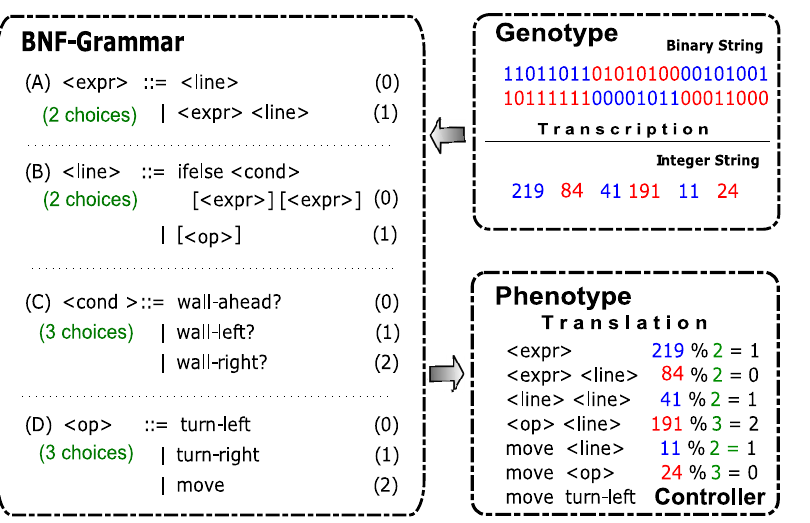
Figure 4. A process of mapping a genotype (binary) to a phenotype (controller/program) using genetic encoding (GE) is demonstrated. The binary genotype is divided into segments called codons, which are then transcribed into an integer string. This integer string is then used to choose production rules from a predefined grammar, which are then translated into a sequence of actions